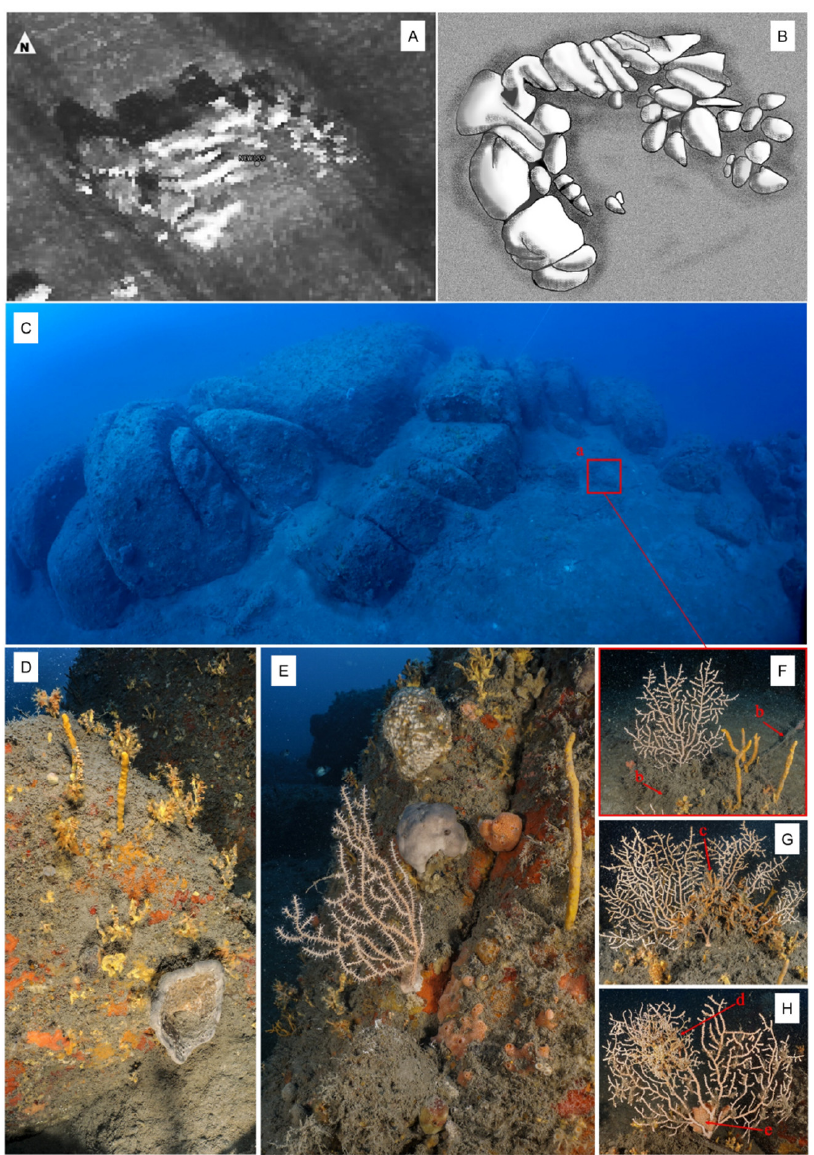
All the recorded colonies of E. verrucosa were photographed. The multi-zoom pho- tographic approach [36] was used to characterize the site geomorphologies, the benthic assemblages, and in particular, the presence of E. verrucosa , and the occurrence of epibionts and damages on the sea fans (Figure 2).